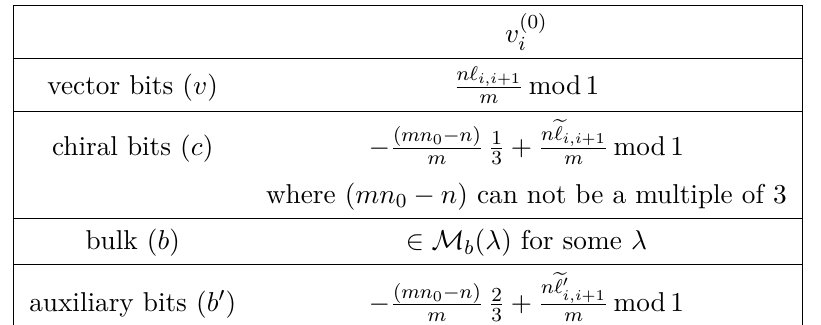
) that enter in (1.17) are defined ij ) do not contribute to the bit ij